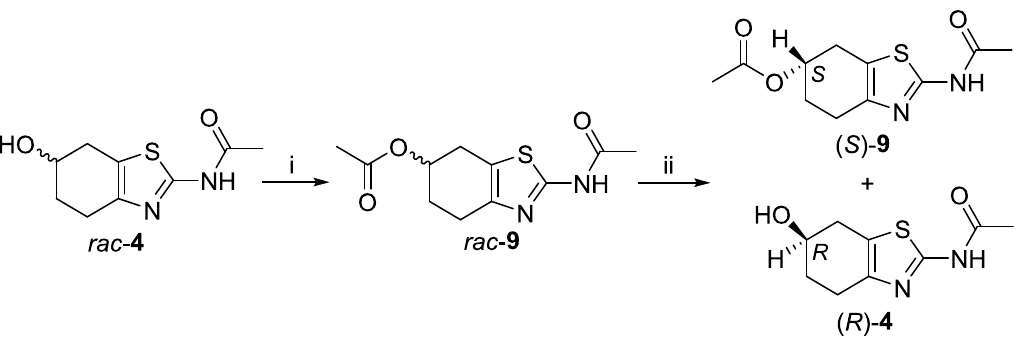
Table 1. Enzyme-catalyzed hydrolysis of acetate rac - 9 .